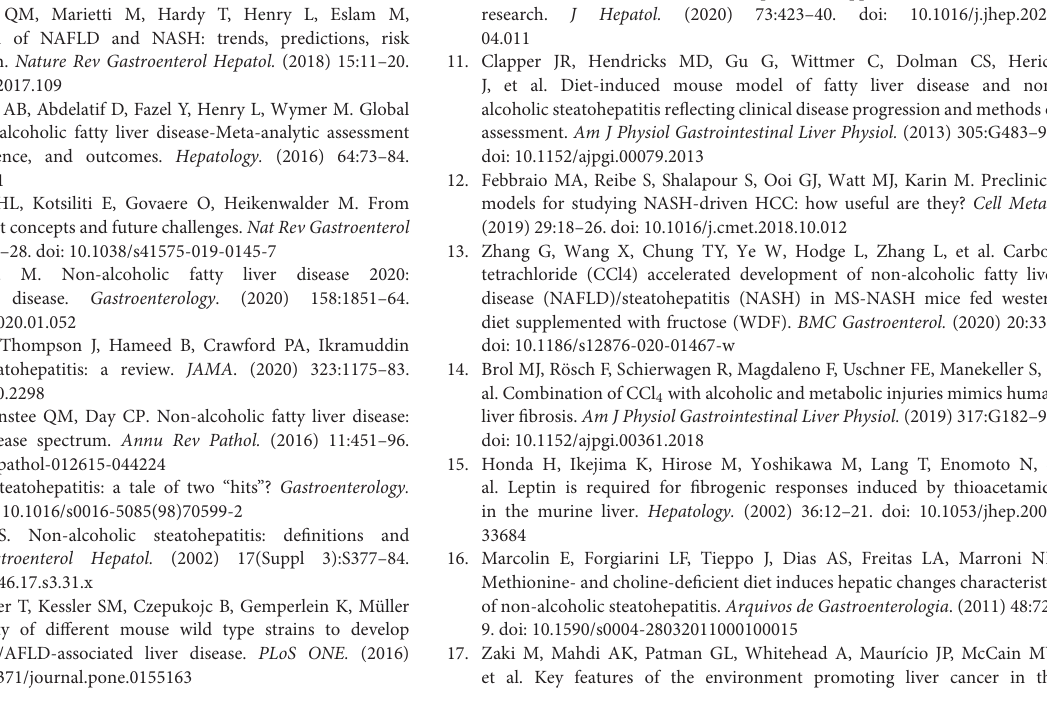
Supplementary Table 16 | Top pathways associated with upregulated proteins altered with Obeticholic acid (OCA). Supplementary Table 17 | Top pathways associated with downregulated proteins altered with Obeticholic acid (OCA). Supplementary Table 18 | Top pathways associated with upregulated (and common) proteins altered with Aquamin ® and Obeticholic acid